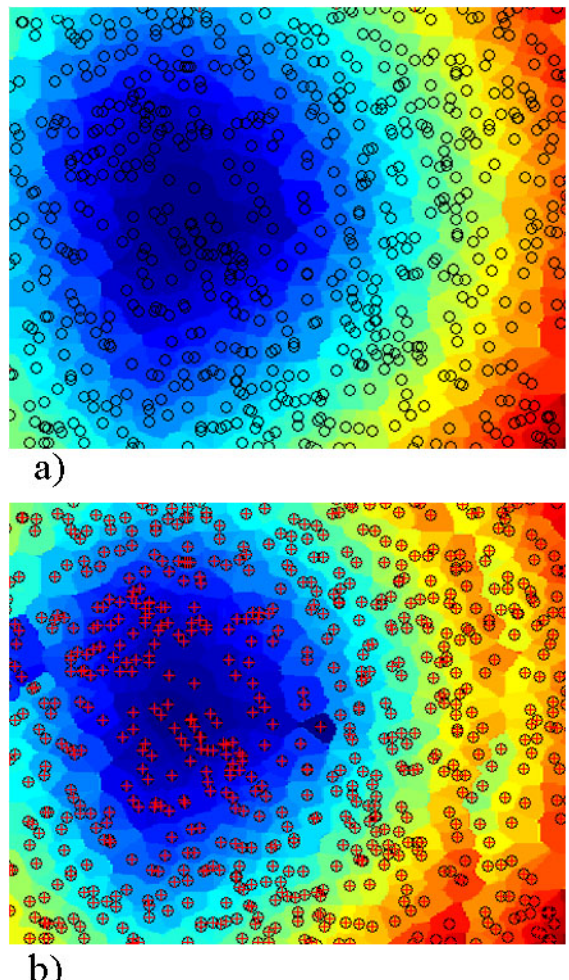
Figure 3. Unwrapped interferograms. a) An unwrapped interferogram which is the result of proposed approach. b) An interferogram is unwrapped by PDV method. Black circles shows PS which is unwrapped correctly, while circles filled by red crosses are unwrapped incorrectly. It is noticeable that presented approach has unwrapped phases correctly, while PDV was completely unable to unwrap phases accurately. The RMSE of true unwrap phases and the result of presented approach is depicted in figure 4.